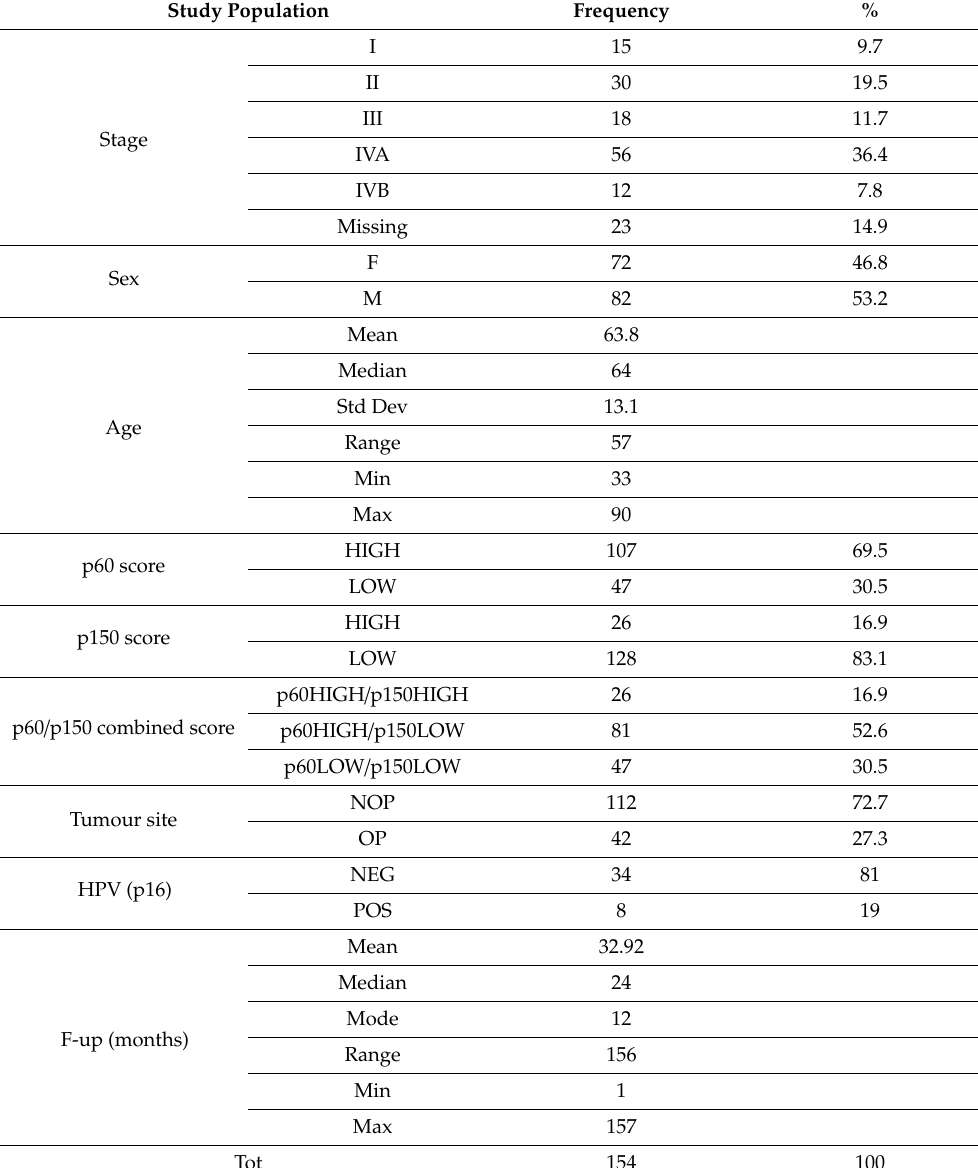
Descriptive statistics of the studied population. NOP, non-oropharyngeal tumours; OP, oropharyngeal tumours. HPV positivity (p16 IHC) is only reported for oropharyngeal squamous cell